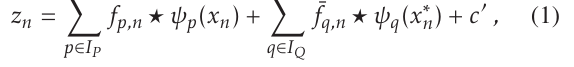
Figure 2. Dataflow graph model of the predistortion